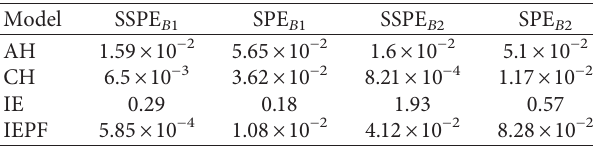
Table 9: Stability of each model for example 2.